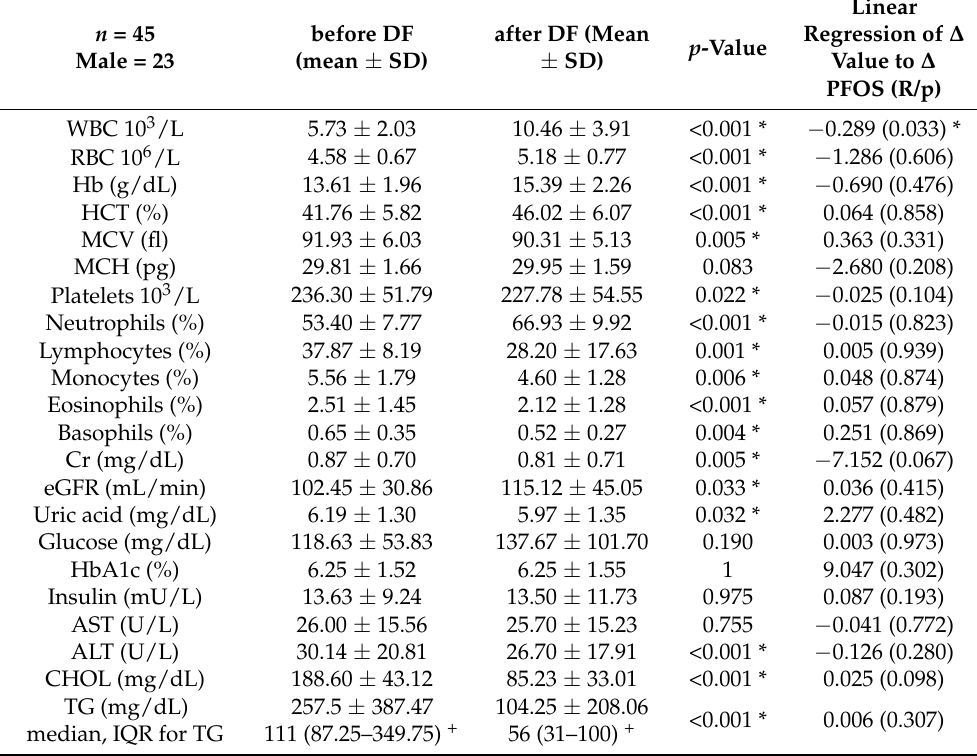
Table 2. Biochemical profile before and after DF, and linear regression of changed values with